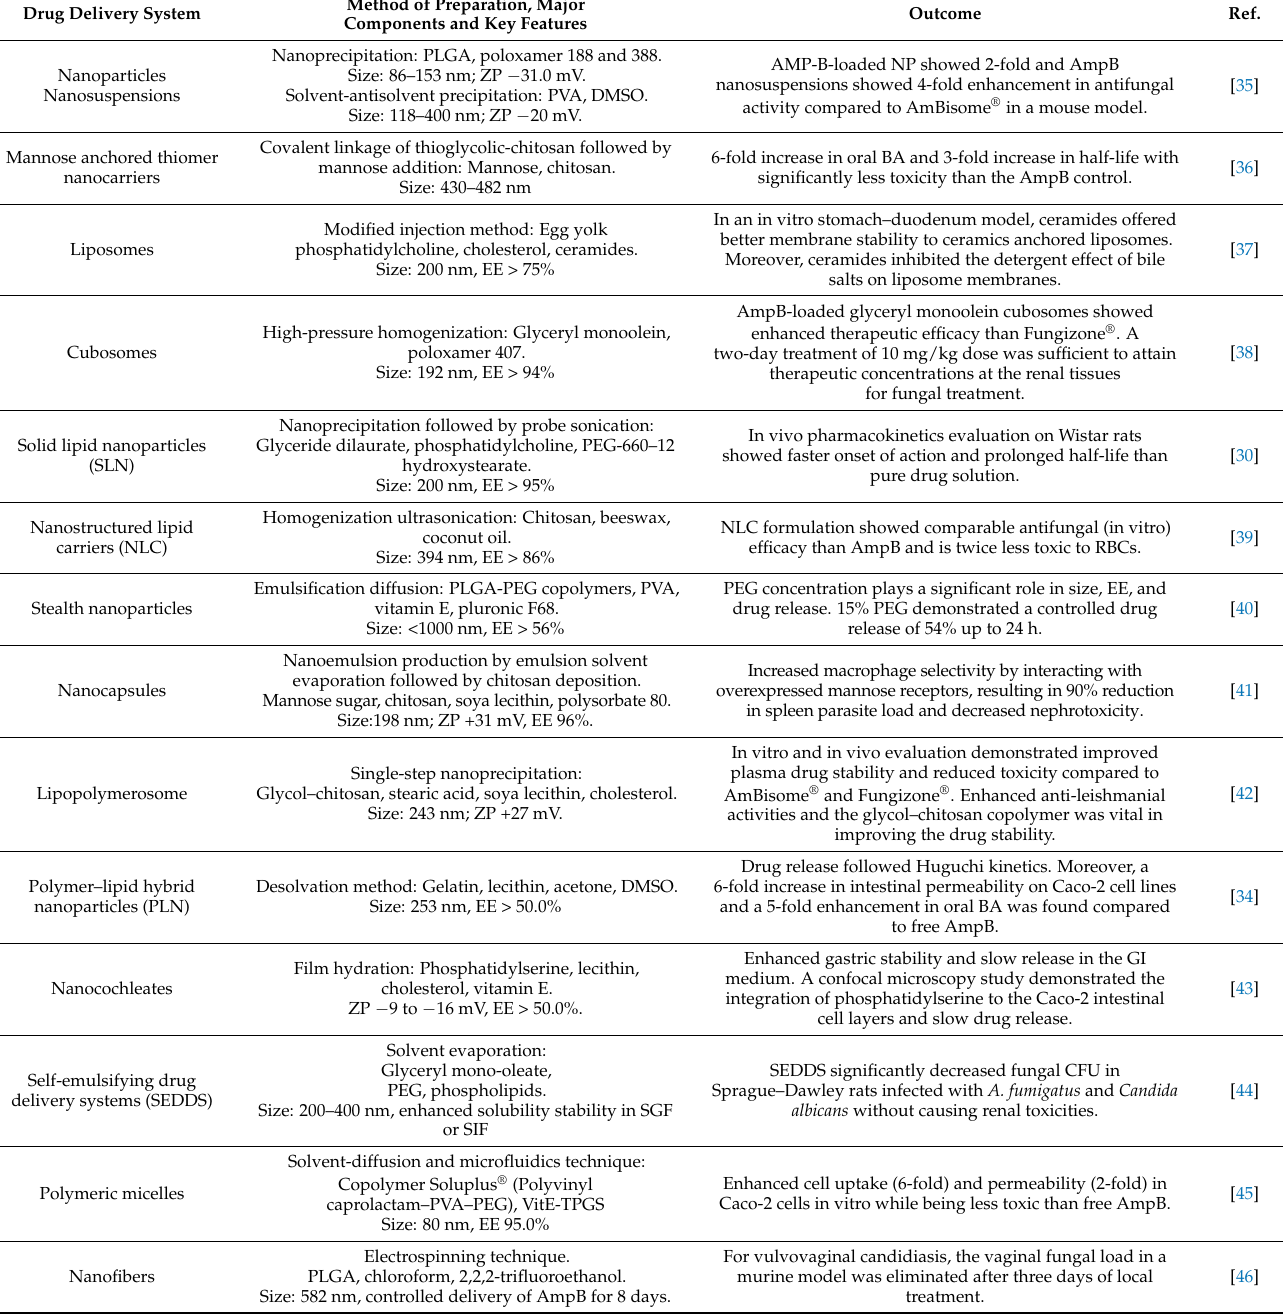
Table 1. Summary of in vitro and in vivo studies on different types of oral AmpB